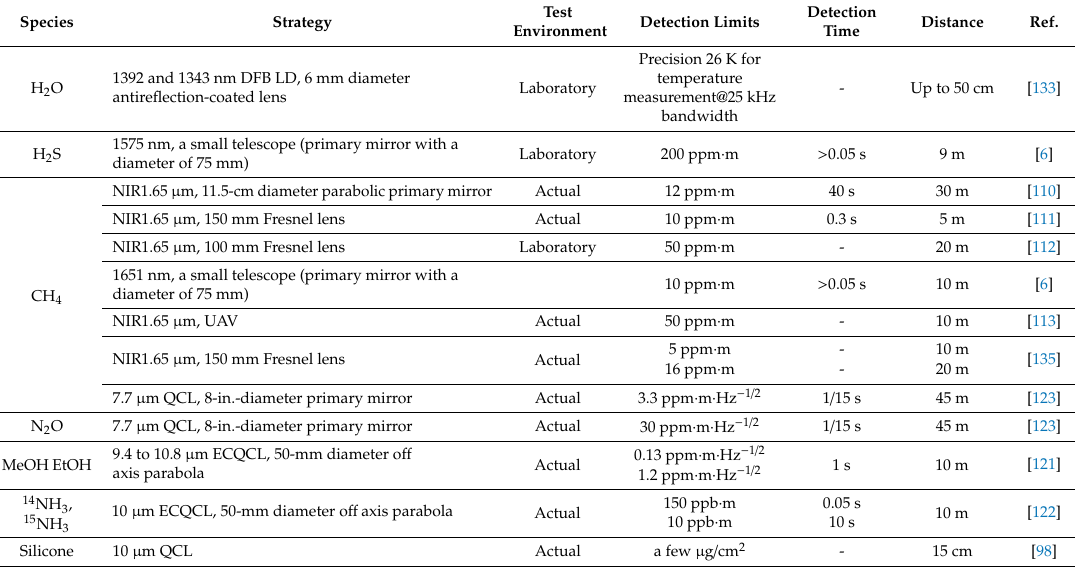
Table 3. Recent advances in TDLAS stando ff detections with non-cooperators. Species Strategy Test